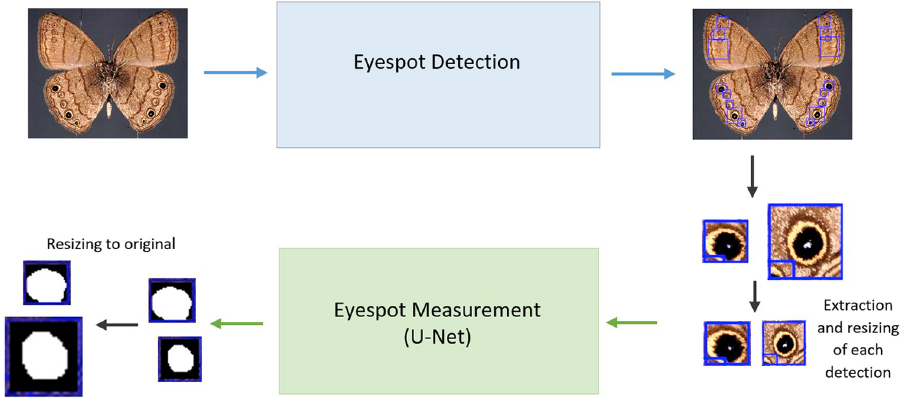
Fig 3. Overview of the two CNNs approach for first detecting and then measuring, spots or eyespots on images of butterfly wings.